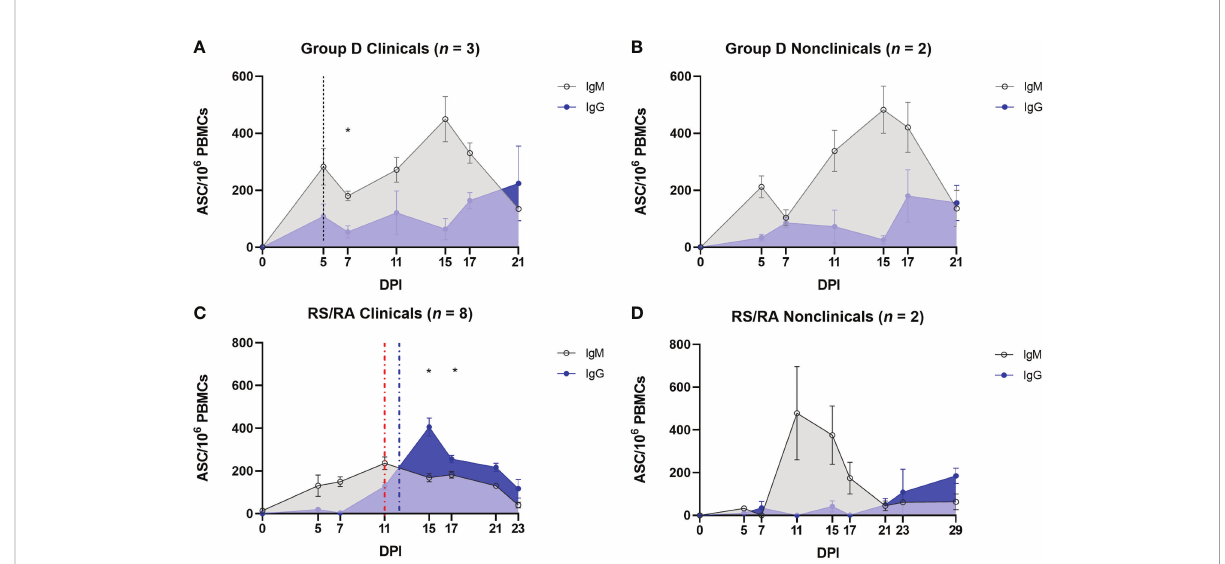
FIGURE 9 Protection against LSD is associated with a robust LSDV – speci fi c IgM response following arthropod – inoculation but not needle – inoculation. PBMCs were isolated from heparinised blood from needle – inoculated (A, B) and arthropod – inoculated (C, D) calves at the time points shown, and stimulated overnight with live LSDV. Antibody secreting cells were then labelled with bovine anti – IgM or bovine anti – IgG antibodies. Spots were read using an ImmunoSpot 7.0 reader and ImmunoSpot SC suite (Cellular Technology Limited). Results were manually validated for false – positive results and expressed as the mean number of ASCs/million. Results are expressed as group mean ASCs/10 6 PBMCs ± standard error of the mean. Red dotted line represents the onset of lesions for group RS cattle and the blue dotted line for group RA cattle. Data corrected to mock uninfected cell lysate